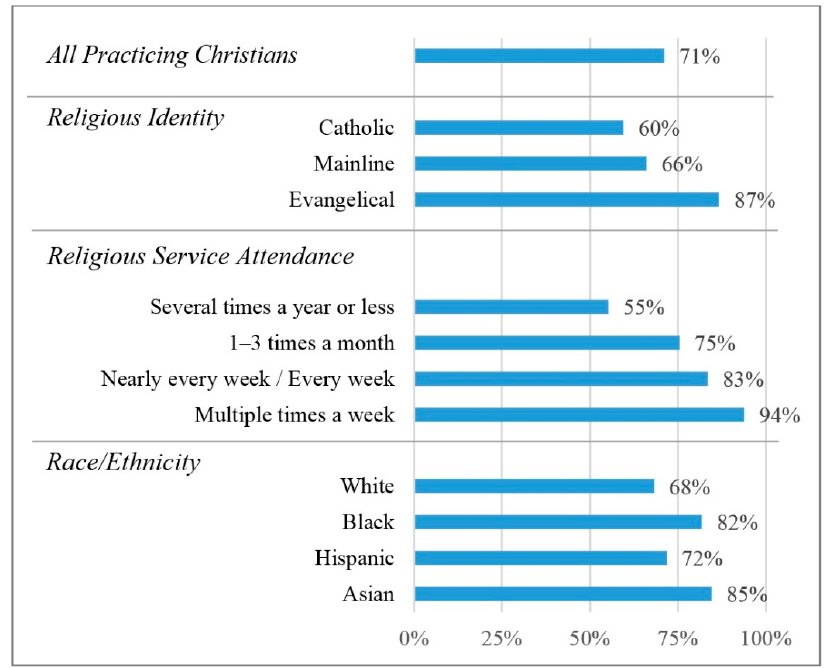
Figure 2. % of people who somewhat or strongly agree that their faith guides them through stressful times in their work-life (overall and by subgroup).